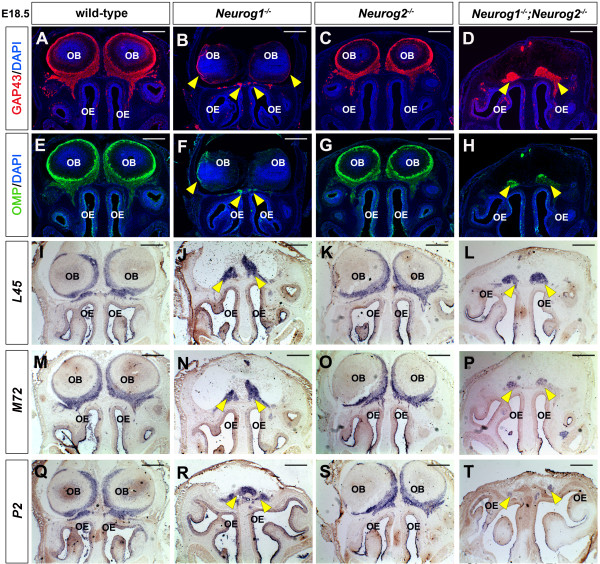
Neurog1 −/− and Neurog1/2 −/− olfactory sensory neurons express mature markers but fail to innervate olfactory bulb. (A) to (H) Coronal sections of the embryonic day (E) 18.5 OB showing expression of GAP43 (red, A to D) and OMP (green, E to H) with DAPI (blue, A to H) in wild-type (A,E), Neurog1−/− (B,F), Neurog2KI/KI (C,G) and Neurog1/2−/− (D,H) embryos. Yellow arrows denote loss of OSN innervation of the OB in Neurog1−/− and Neurog1/2−/− (B,D,F,H) embryos. (I) to (T) Expression of odorant receptors L45 (I) to (L), M72 (M) to (P) and P2 (Q) to (T) in E18.5 wild-type (I,M,Q), Neurog1−/− (J,N,R), Neurog2KI/KI (K,O,S) and Neurog1/2−/− (L,P,T) embryos. Note that the lack of an apparent OB in Neurog1−/− sections is because the OB is shortened along the proximodistal axis, and hence does not fill the rostral-most part of the cavity in the skull, where OR expression levels are the highest (J,N,R). GAP43, growth-associated protein 43; OB, olfactory bulb; OE, olfactory epithelium; OMP, olfactory marker protein; OSN, olfactory sensory neuron. Scale bars: 500 μm (A) to (T).